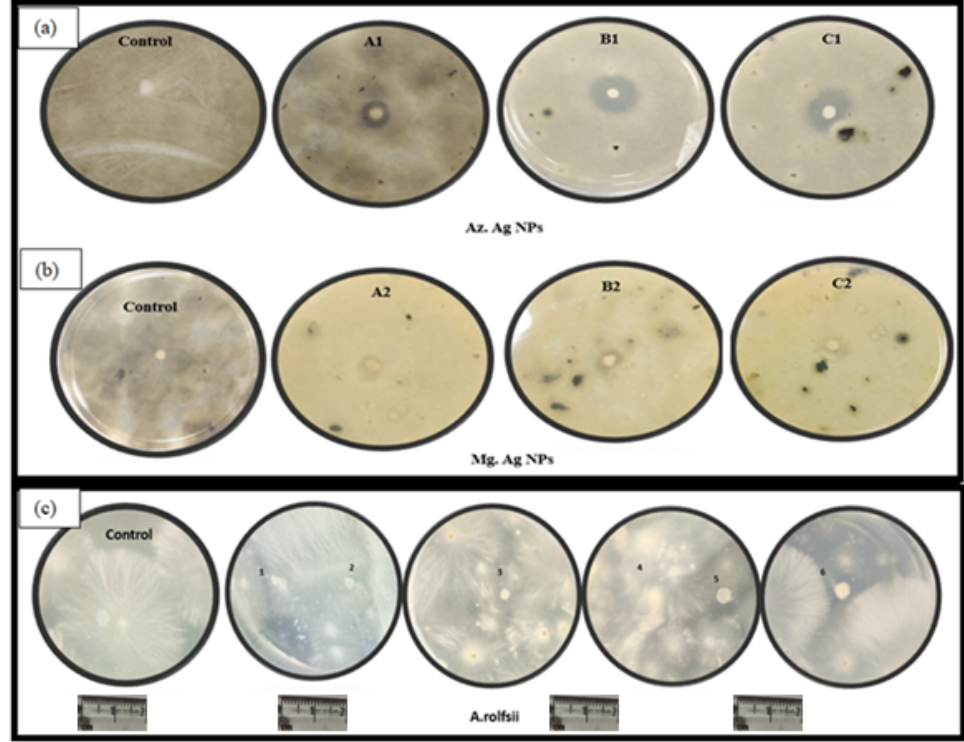
Figure 12. ( a ) A-AgNPs (A1, B1, C1) and ( b ) M-AgNPs (A2, B2, C2) treatment against A. alternata